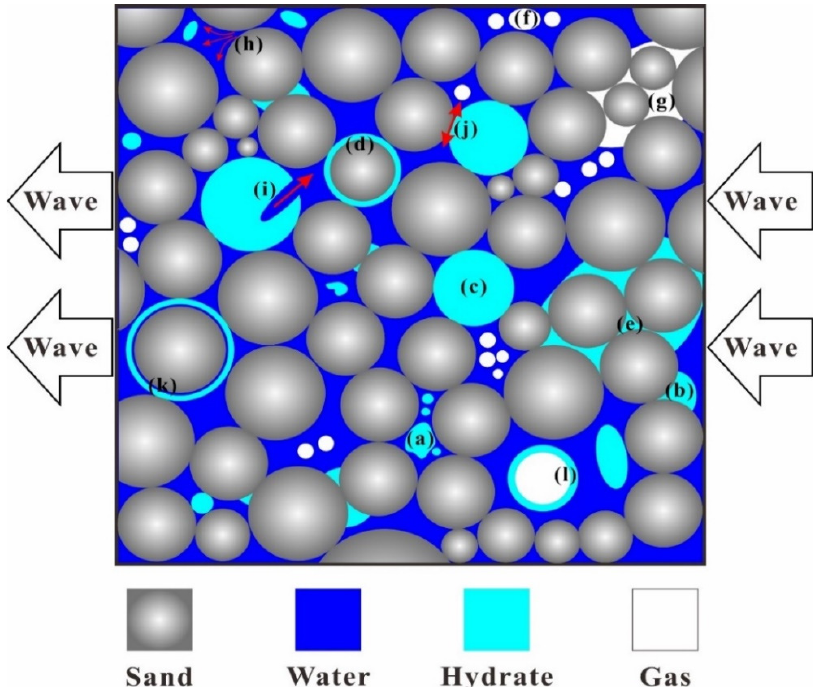
Figure 2. Proposed hydrate morphologies and attenuation mechanisms associated with GHBS: ( a ) pore-filling hydrate morphology, ( b ) contact cementing hydrate morphology, ( c ) load-bearing hydrate morphology, ( d ) envelope cementing hydrate morphology, ( e ) patchy hydrate morphology, ( f ) uniformly distributed gas bubble, ( g ) patchy gas bubble, ( h ) global Biot flow, ( i ) squirt flow in the porous hydrate, ( j ) cementation between hydrate and sand grains, ( k ) water film between hydrate and sand grains, and ( l ) hydrate film enveloping gas bubble. The grey color indicates sand, the blue color indicates water, the bright blue indicates hydrate, and the white color indicates gas bubble.